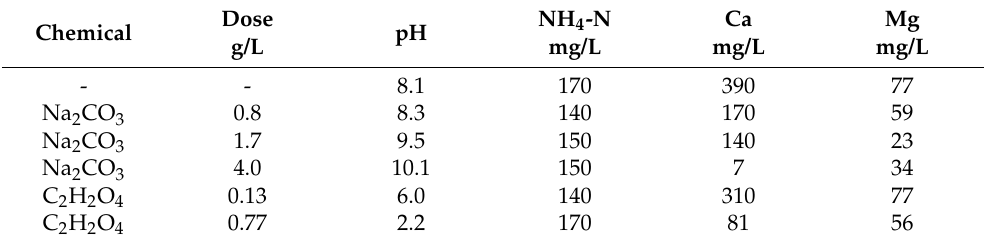
Table 2. Precipitation of mine water sample. Concentrations were measured from the 0.45 µ m